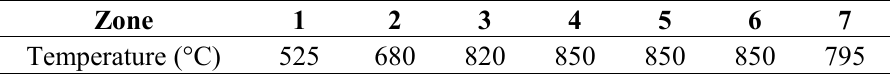
Table 2. Sintering process parameters of the silver paste.